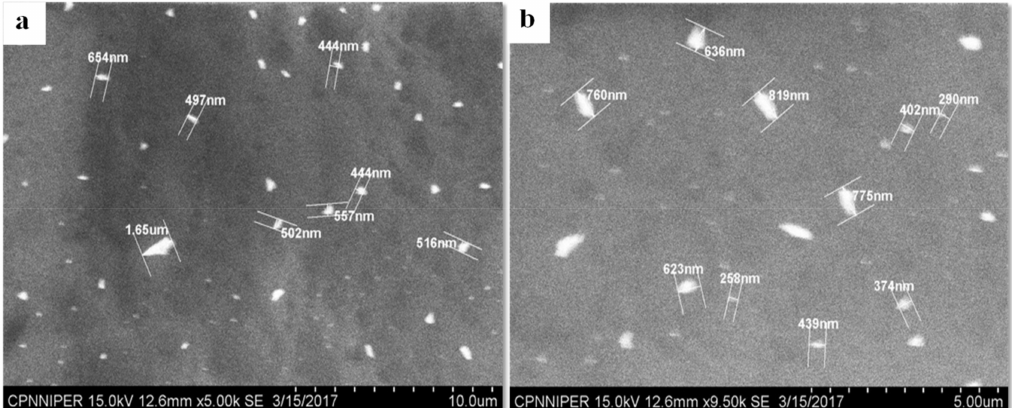
Figure 7. SEM images of CEL_NCSD dispersion. ( a ) and ( b ) images show CEL nanocrystals below 1000 nm.